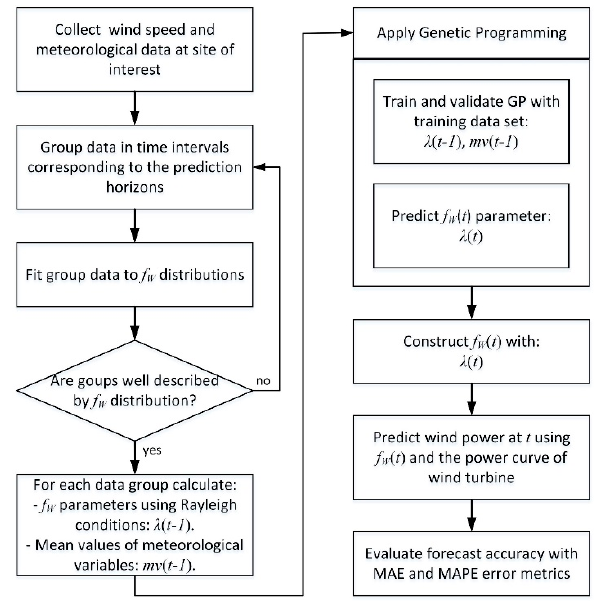
Figure 1. The overarching methodology.